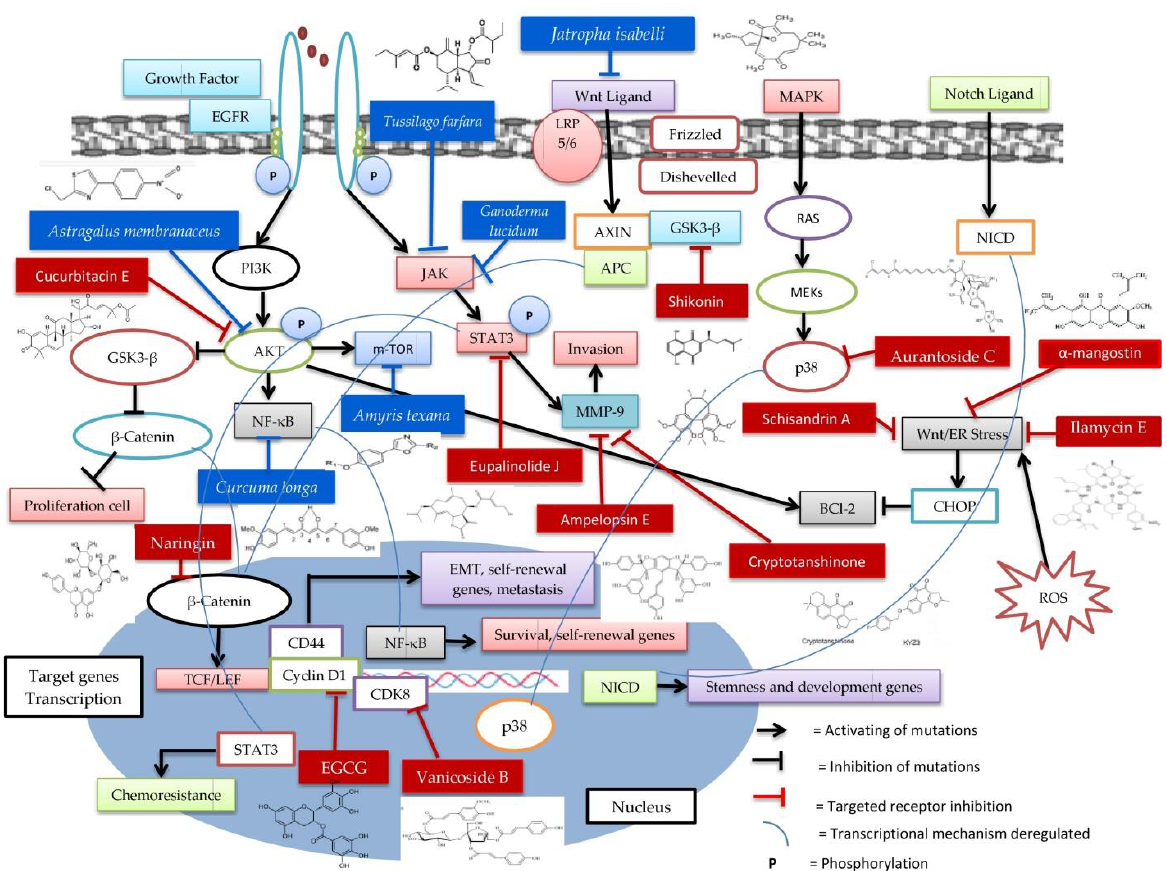
Figure 4. The role of bioactive compounds (red box) and plant extracts (blue box) to inhibit targets involved in TNBC regulation.